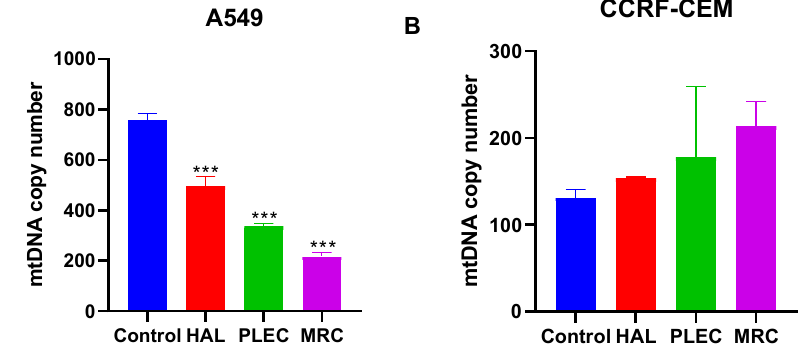
Figure 6. Mitochondrial DNA copy number in A549 ( A ) and CCRF-CEM ( B ) cells measured by real-time quantitative PCR. The cells were exposed to HAL, PLEC and MRC for 24 h and then the DNA was extracted. Values are expressed as means ± SD. *** p < 0.001 vs. control cells.